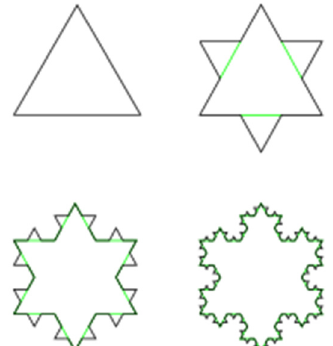
Figure 4. The first four iterations of the Koch snowflake (source www.wikipedia.org) a